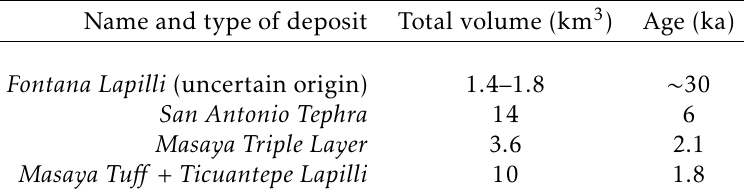
Table 1 – Basaltic Plinian eruptions from Masaya